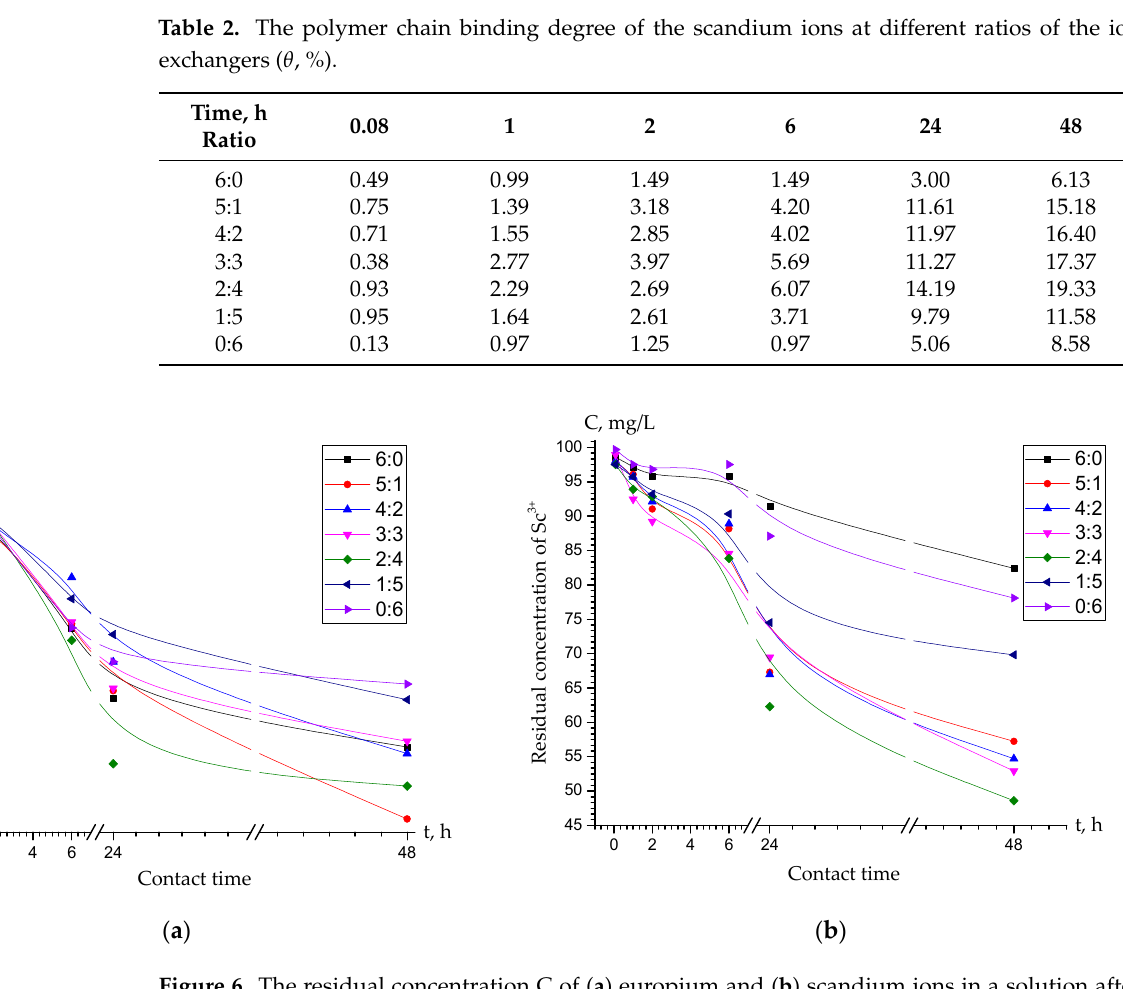
Figure 6. The residual concentration C of ( a ) europium and ( b ) scandium ions in a solution after sorption as a function of time.